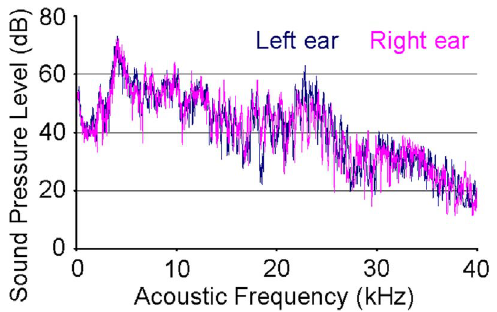
Figure 1. Power spectra of fMRI auditory stimulus. Acoustic power spectra measured from the distal tips of the left and right ear sound tubes at the 0dB interaural level difference (ILD) setting. The total sound pressure level (SPL) in each ear at 0dB ILD was 86dB. Measurements were made with an omnidirectional condenser micro- phone (M50, Earthworks, USA) and sampled using a recorder (FR2, Fostex, Japan). These spectra are close estimates of the sound stimuli heard by both ears. The spectral and temporal properties of the sounds heard by both ears were very similar.